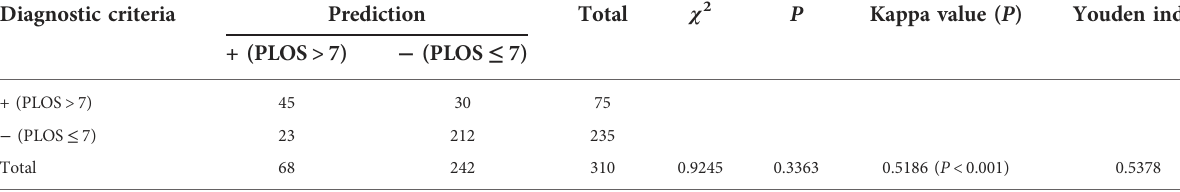
TABLE 3 Discrimination and classi fi cation ability of the prolonged PLOS prediction model in lumbar fusion surgery. Diagnostic criteria